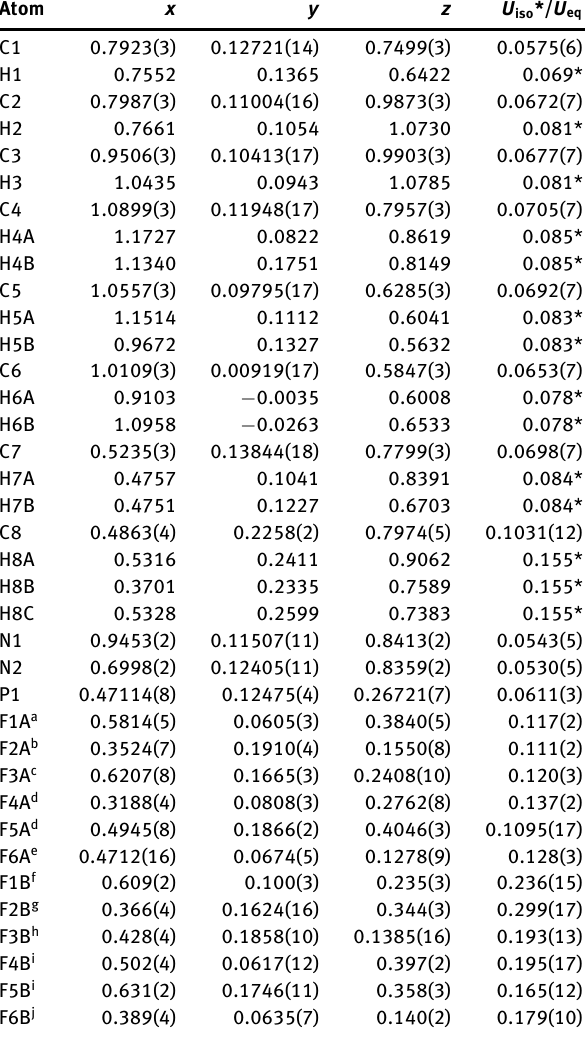
Table 2: Fractional atomic coordinates and isotropic or equivalent isotropic displacement parameters (Å 2